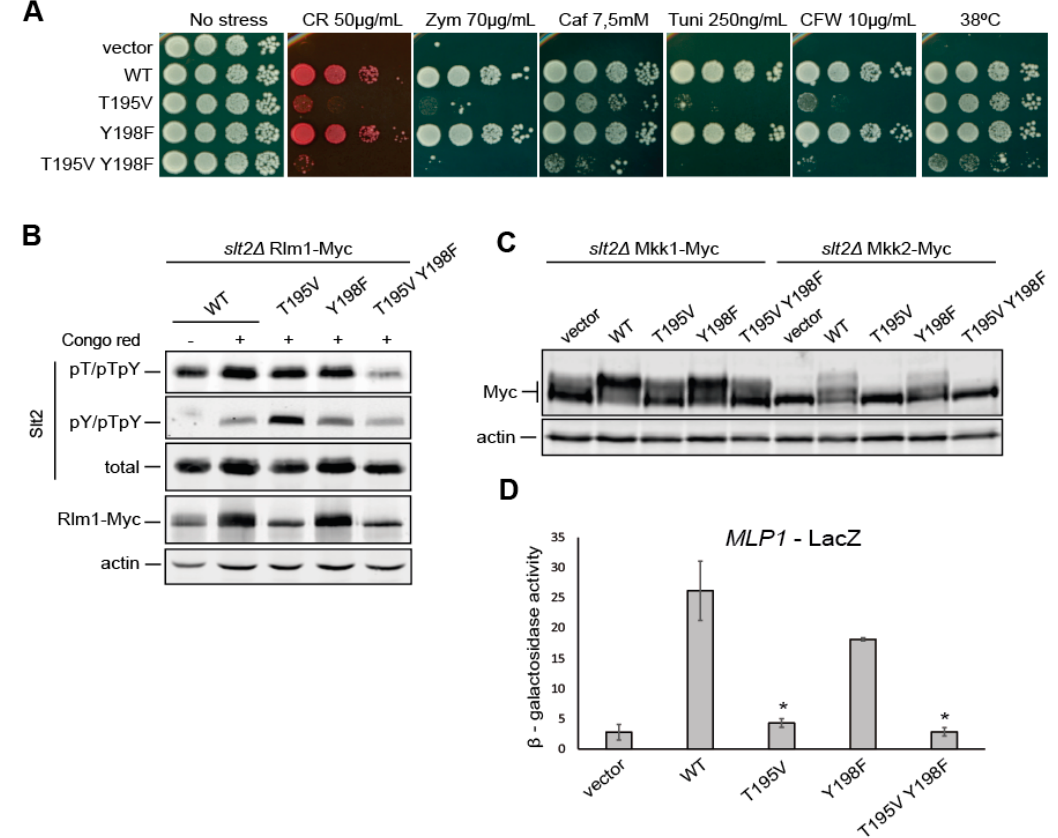
Figure 6. Analysis of the activity of Slt2 mutated in the conserved residues T195 and Y198. ( A ) Ten-fold serial dilutions of BY4741 slt2 Δ -RLM1Myc cells bearing the pRS316 plasmid alone (vector) or expressing Slt2 (WT), Slt2 T195V , Slt2 Y198F , or Slt2 T195V Y198F . Cells were spotted onto YPD plates in the absence (no stress) or presence of the indicated stimuli. ( B ) The same cells as in ( A ) were grown to the mid-exponential phase in YPD and stimulated with 30 µg/mL of CR for 2 h. Cell extracts were resolved by SDS–PAGE, and analyzed by immunoblotting with anti-Slt2-pT/pTpY and anti-Slt2-pY/pTpY, as in Figure 1; anti-Mpk1 (total); anti-MYC 4A6; and anti-actin antibodies. ( C ) Yeast extracts from slt2 Δ MKK1-myc (YMJ30 strain) and slt2 Δ MKK2-myc (YMJ31 strain) cells transformed with the same plasmids as in ( A ) were resolved by SDS–PAGE as in ( B ) and analyzed by immunoblotting with anti-Myc 4A6 and anti-actin antibodies. ( D ) β -galactosidase activity of cell extracts from slt2 ∆ (Y00993 strain) co-transformed with p MLP1-LacZ and the same plasmids as in ( A ) after incubation with 30 µg/mL of CR for 2 h. Data represent the average of the activity of three independent transformants. Error bars indicate the standard deviation. One asterisk (*) indicates a p -value of <0.05, assessed by Student’s t-test, and refers to wild type Slt2 (WT) activity. A representative assay from three different experiments with distinct transformants is shown.